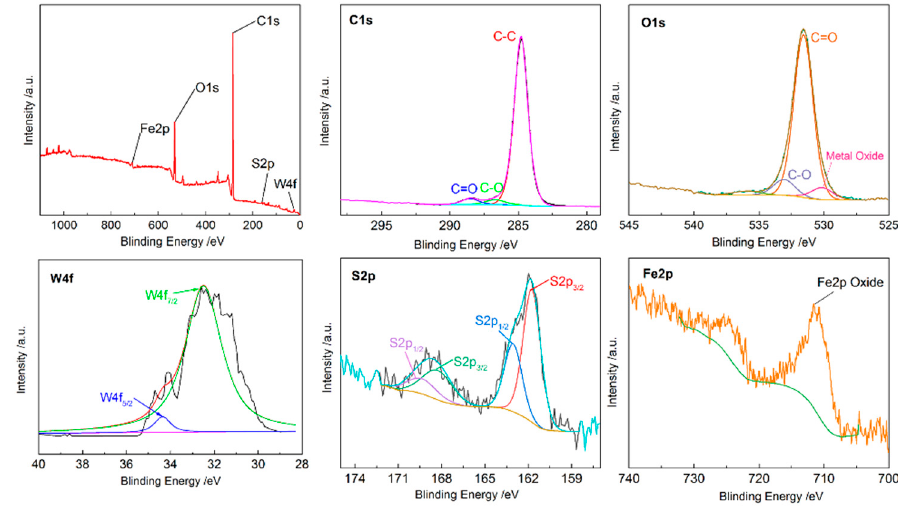
Figure 8. The XPS results of the worn surface of the TCW sample.